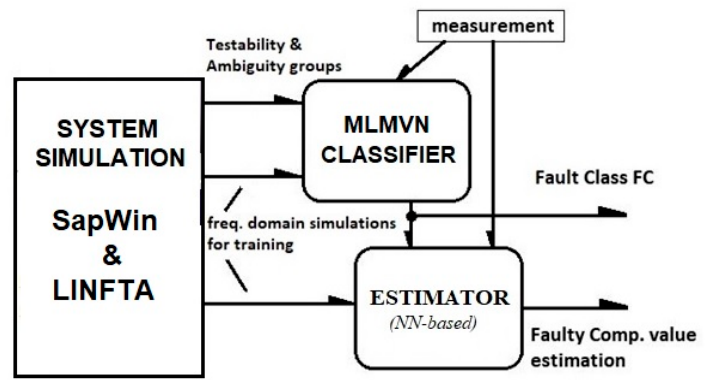
Figure 1. Block diagram of the fault diagnosis system. MLMVN: multilayer neural network; LINFTA: linear invariant network fast testability analysis.